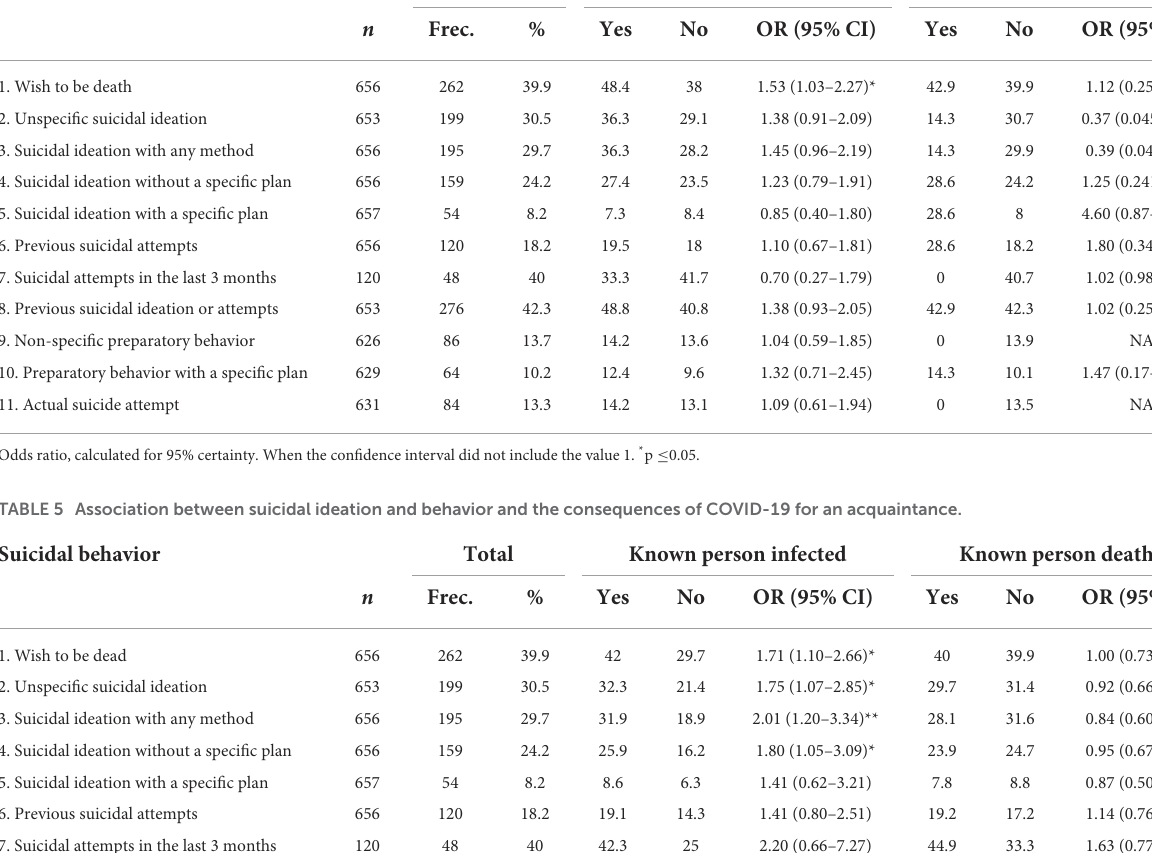
TABLE 4 Association between suicidal ideation and behaviors in relation to having sufferen from the COVID-19 infection. Suicidal behavior